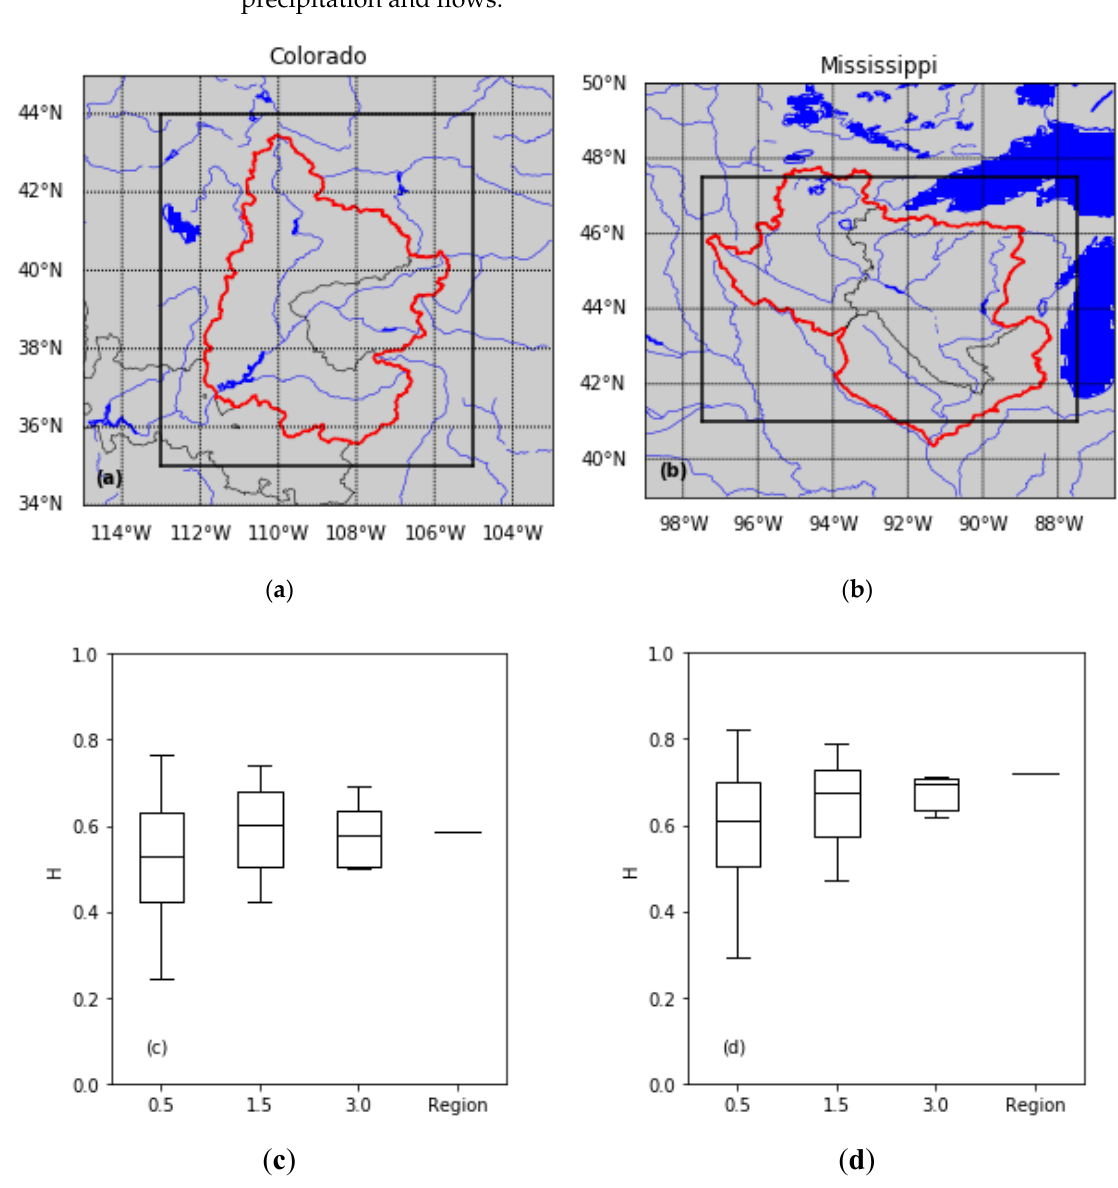
Figure 8. ( a , b ) Catchment boundary boxes; ( c , d ) scale-dependent box plots of H for average annual precipitation for the Colorado at Lees Ferry (1906–2013) and the Mississippi at Keokuk (1901–2013). Estimates of H are presented in Table 2 for the annual average catchment precipitation and annual flows for the Colorado and Mississippi rivers. For the Colorado, there is weak LTP in basin precipitation (Table 2: H = 0.59), reflecting the reversals in fluctuations seen in the CDM plot (Figure 9). However, the fluctuations seen in the CDM plot for annual precipitation in the later decades of the record are damped in the CDM plot for annual flows, indicating that the latter have been declining in this period, resulting in a higher H value for the flows of 0.69. This decline has been mainly attributed to increased evapotranspiration caused by a reduction in albedo from snow loss and the associated rise in the absorption